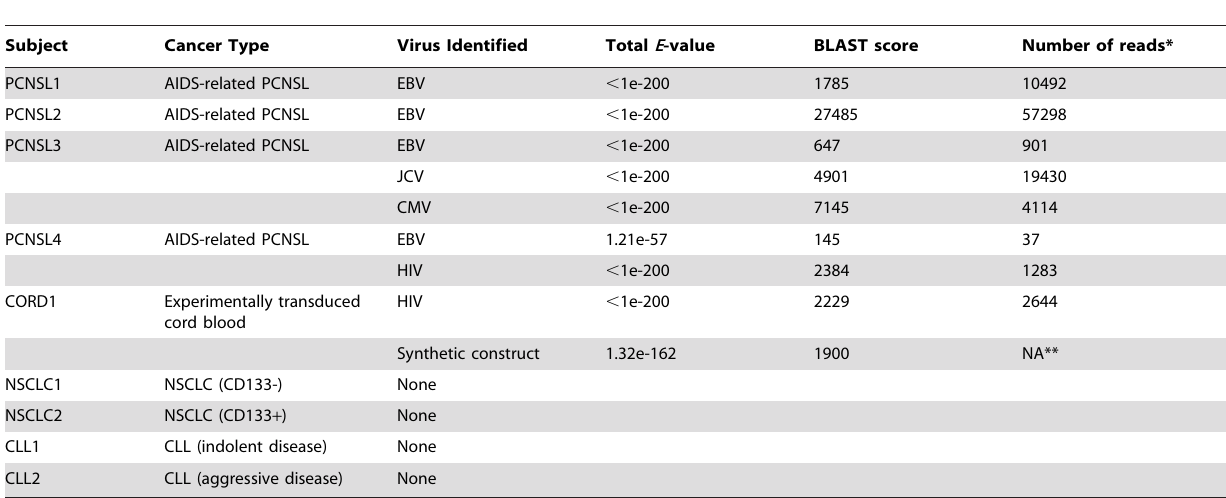
Table 2. Viruses found in each sample and corresponding total E -value and total BLAST